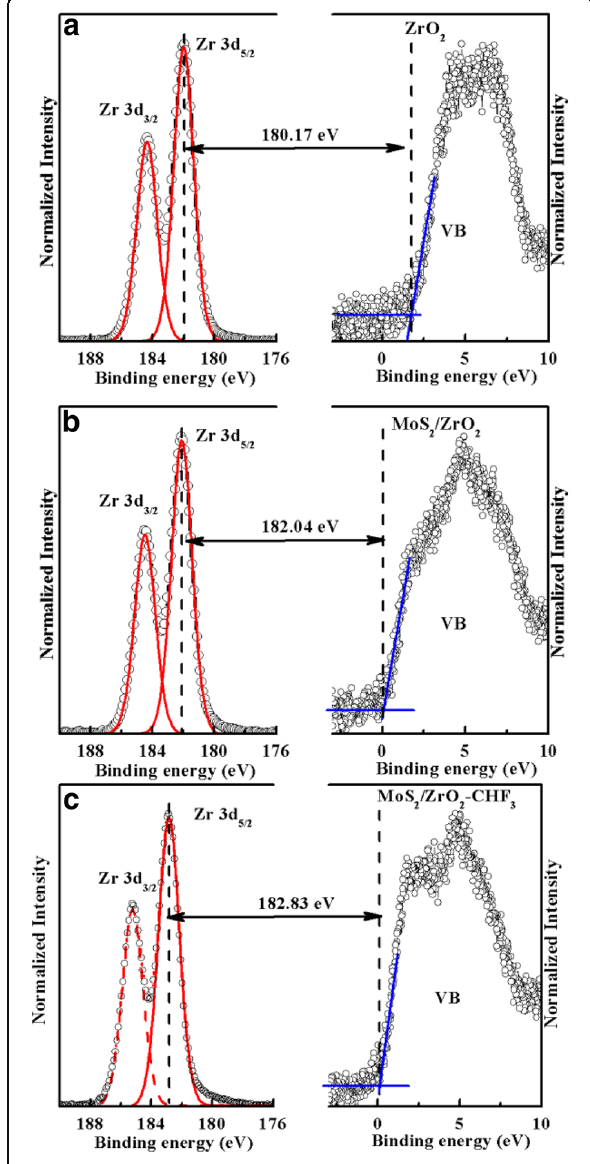
Fig. 2 The core-level Zr 3d and valence band spectra for a bare ZrO 2 oxide, b multilayer-MoS 2 /ZrO 2 sample, and c CHF 3 plasma treated multilayer-MoS 2 /ZrO 2